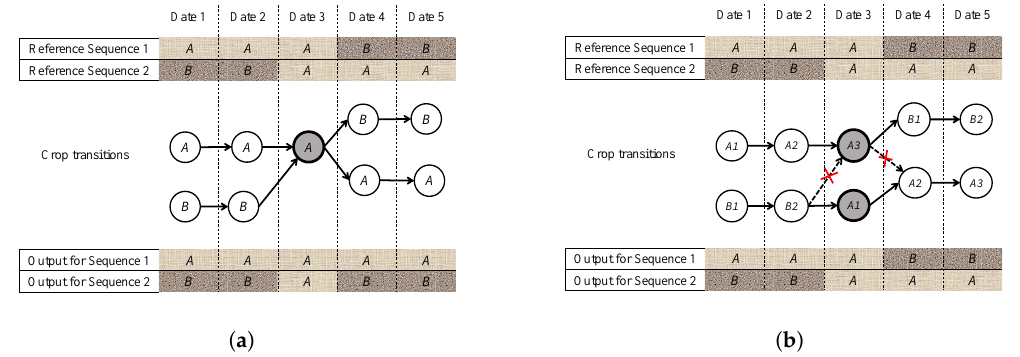
Figure 3. ( a ) Possible wrong solution of MLCS and ( b ) MLCS refinement with the correct solution after incorporating the crop’s sequence lengths information.